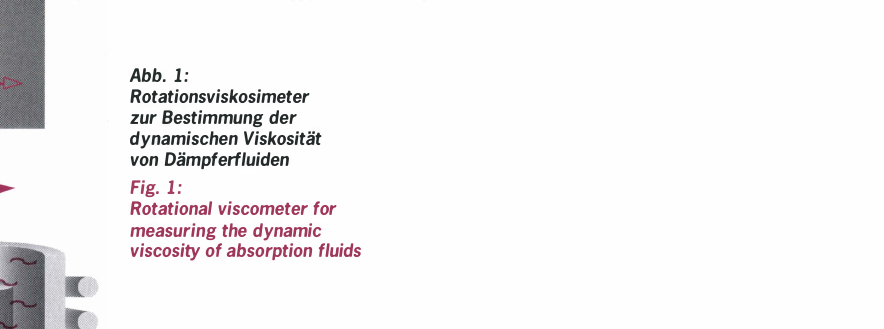
Fig. 1: Rotational viscometer for measuring the dynamic viscosity of absorption